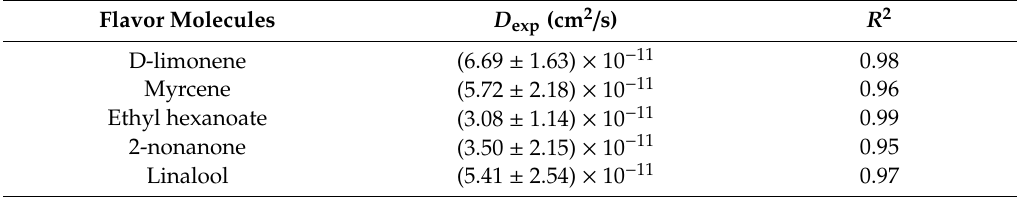
Table 4. Di ff usion coe ffi cients ( D exp ) fitted by experimental